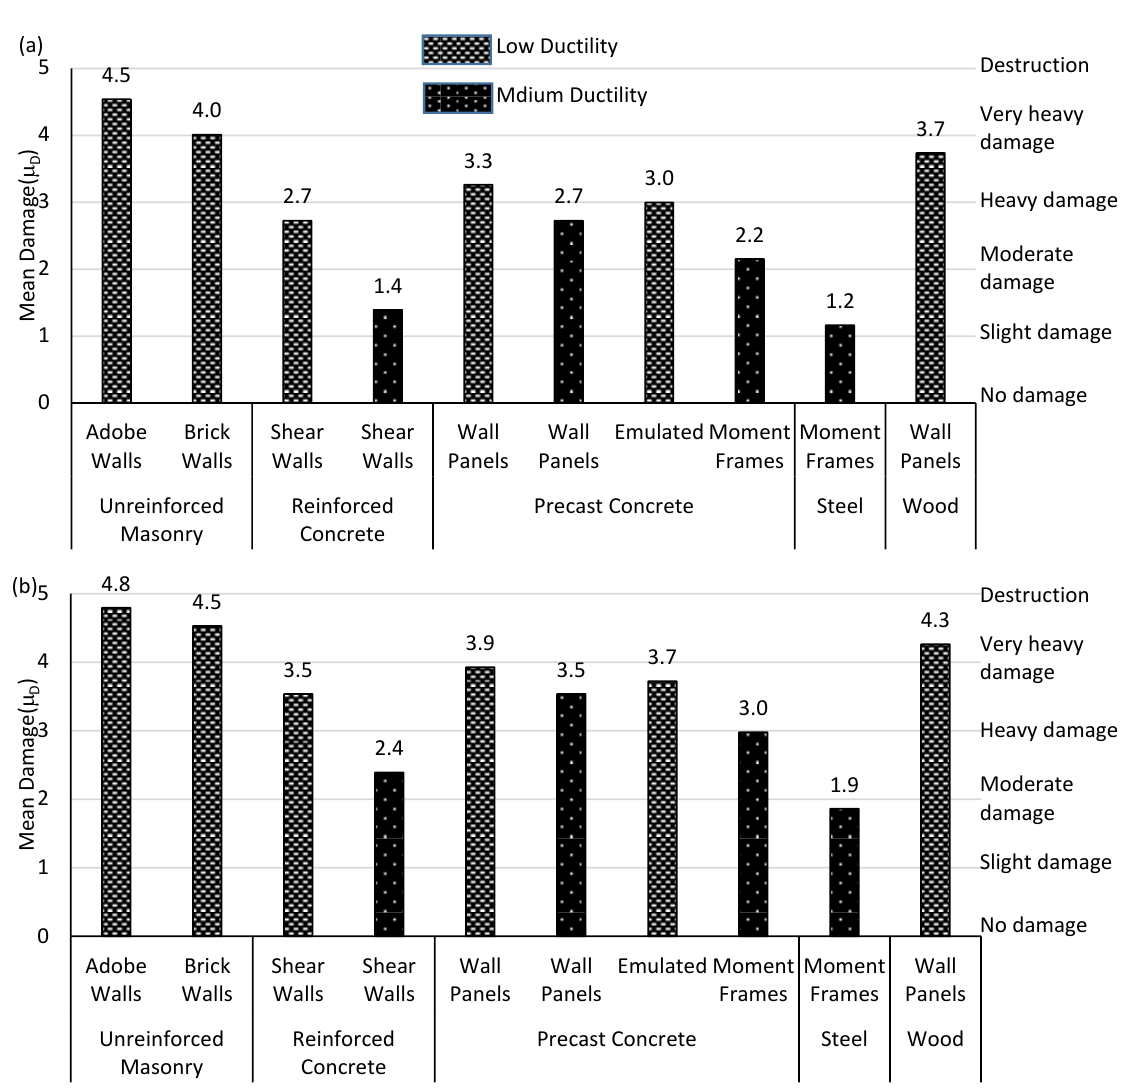
Figure 6. Mean damage for different groups of residential buildings at ( a ) DBE (return period of 475 years); and ( b ) MCE (return period of 2475 years).